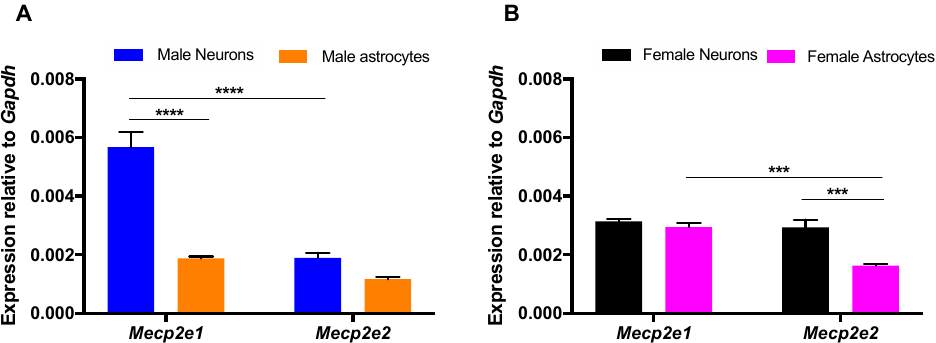
Figure 2. Cell type- and sex-specific expression of Mecp2 isoforms in primary mouse embryonic neurons and astrocytes. The figure illustrates cell type-specific and sex-specific comparison of Mecp2 isoforms in neurons and astrocytes. ( A ) Mecp2 expression in male neurons and astrocytes. ( B ) Mecp2 expression in female neurons and astrocytes. Significant differences are indicated with **** p < 0.0001, *** p < 0.001. For male neurons, male astrocytes, and female astrocytes, N = 3 ± SEM and N = 12 ± SEM (biological replicates are reported as N, while technical repeats of biological replicates are reported as N ). For female neurons, N = 2 ± SEM and N = 8 ± SEM. The transcript levels were normalized to the endogenous control Gapdh .